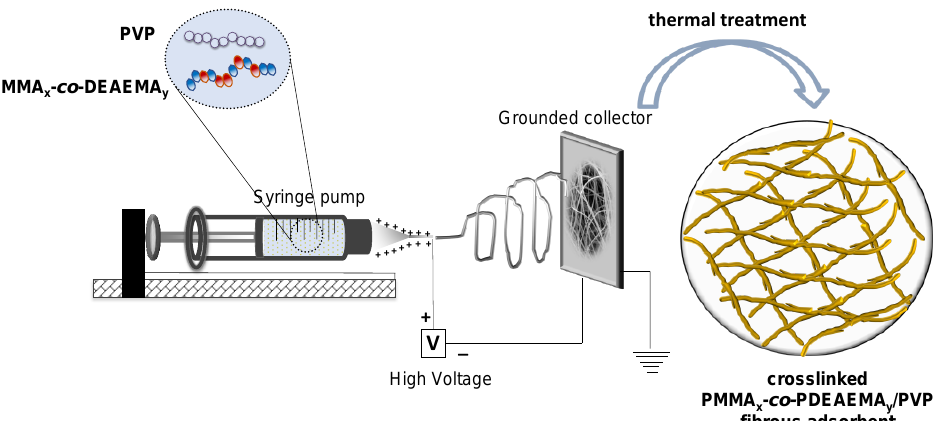
Figure 4. Schematic representation of the electrospinning process employed in the preparation of the PMMA x - co -PDEAEMA y /PVP blended fibrous membrane that was further crosslinked via thermal treatment.